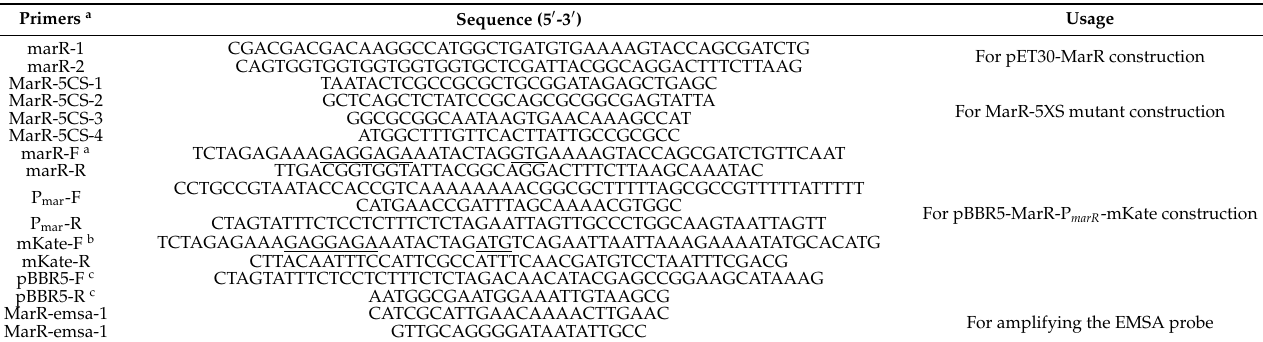
Table 2. Primers used in this